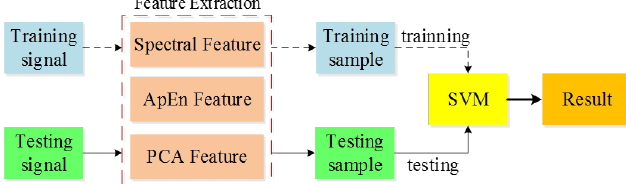
Figure 8. Schematic diagram of the SVM identification model training and